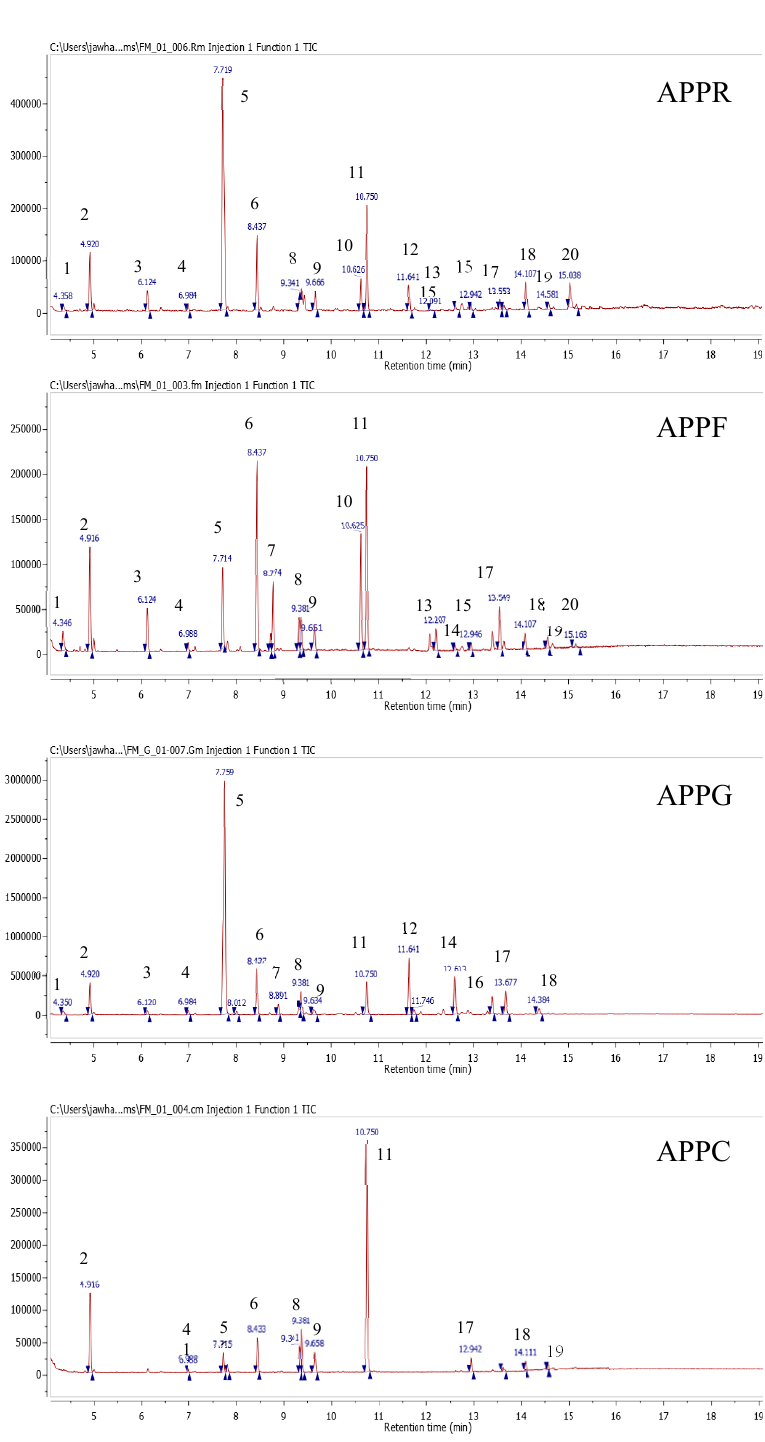
Figure 1. Chromatographic profile of different extracts (roots, seeds, leaves, and capitula) of A. pyrethrum (L).